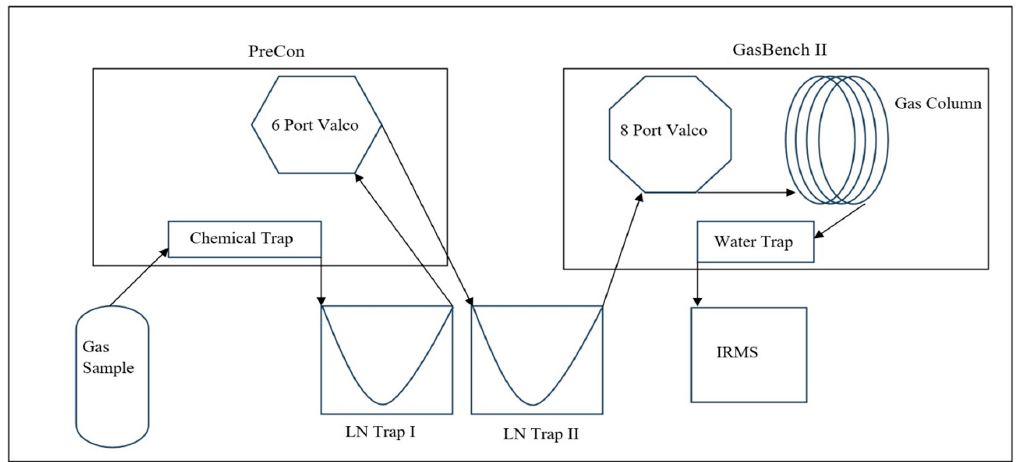
Figure 2. Schematic for the instrumentation of continuous flow measurements for nitrogen isotopes in gas.